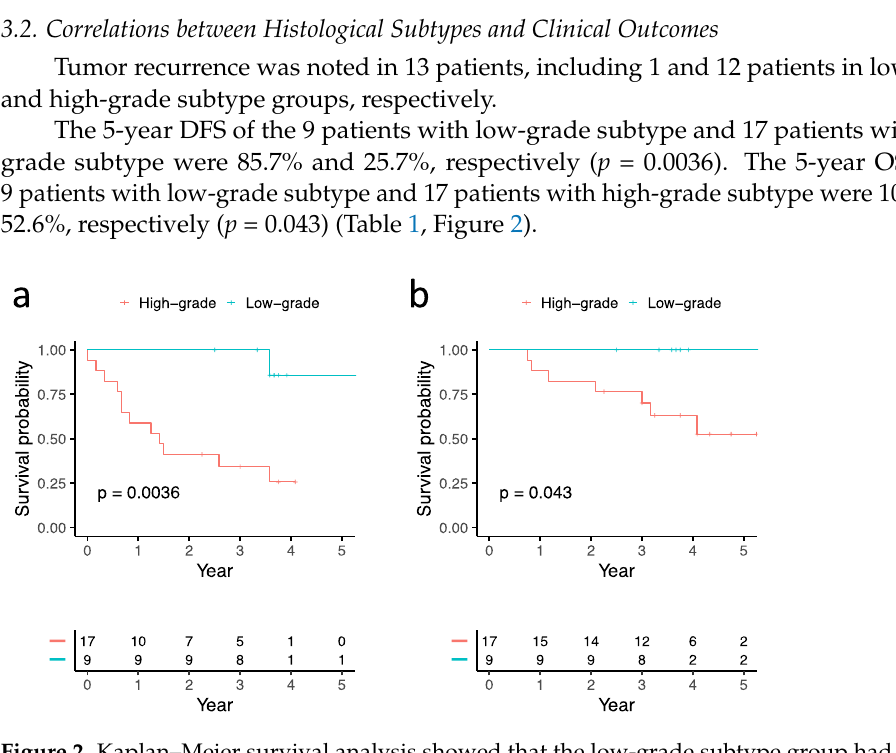
0.940.950.960.970.980.991